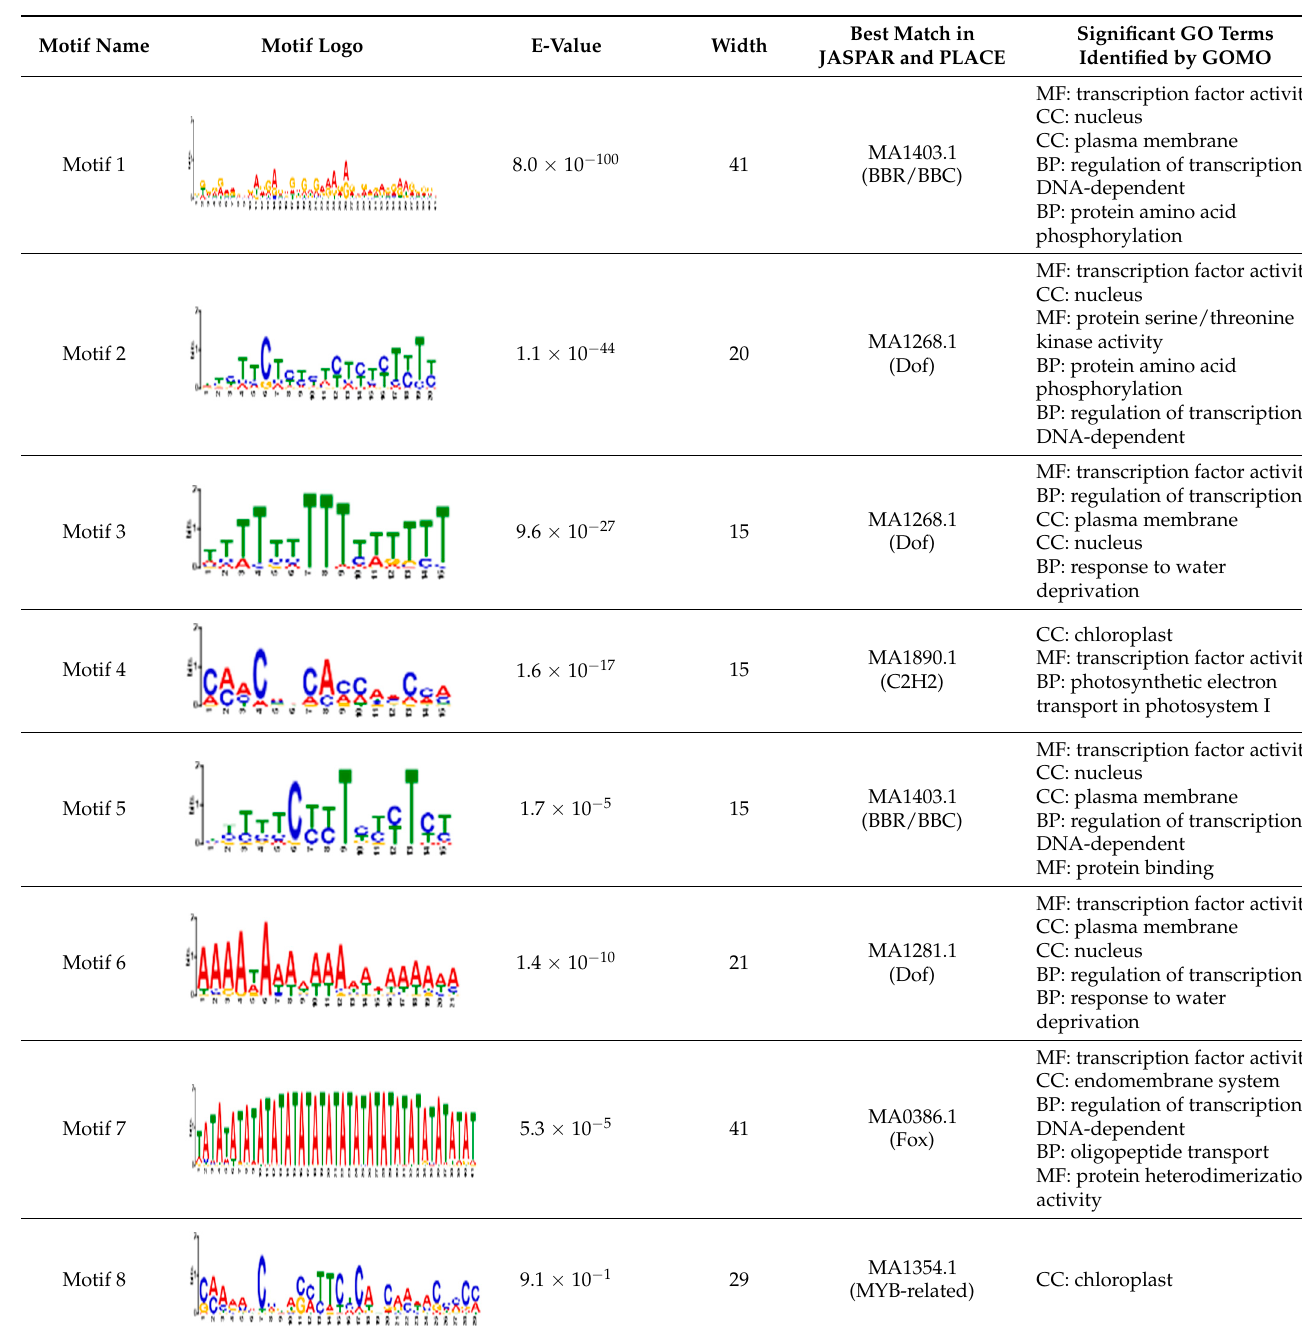
Table 3. The conserved cis-acting elements found in promoters of drought stress DEGs by MEME analysis.